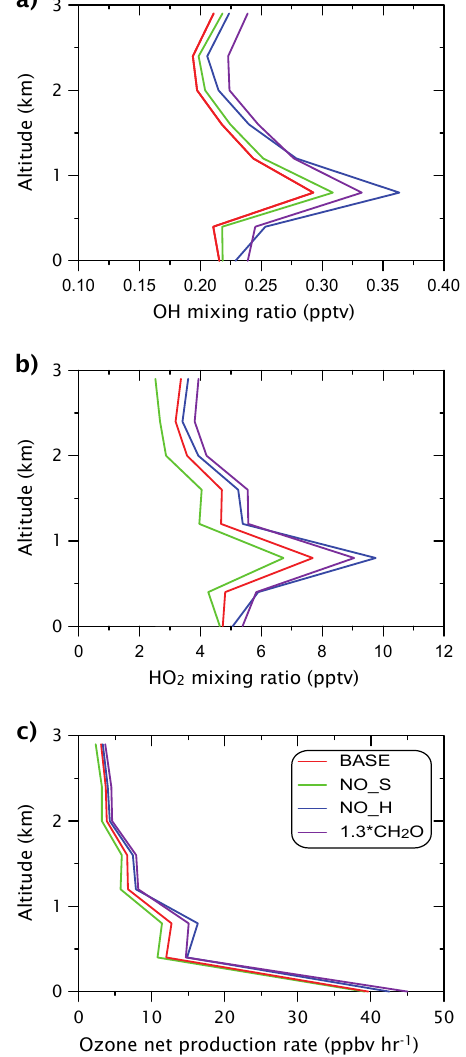
Fig. 12. Vertical profiles of (a) OH, (b) HO 2 , and (c) O 3 production rates, calculated using the NCAR Master Mechanism constrained by measured daytime mean trace gas and aerosol concentrations. BASE refers to the standard simulation, and NO S and NO H to sensitivity simulations without considering SO 2 related reactions and heterogeneous reactions of OH and HO 2 on aerosol surfaces, respectively. “1.3*CH 2 O” refers to the simulations with a 3ppbv increase of the CH 2 O mixing ratio at the surface and a 30% increase aloft relative to the BASE